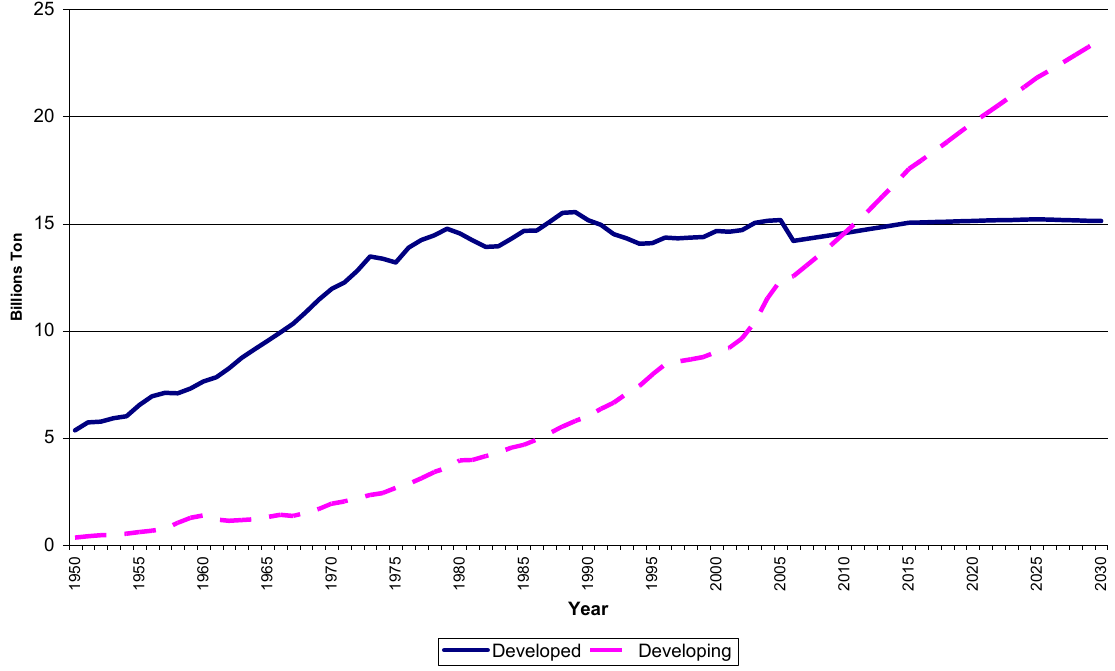
emission by developed and developing Figure 1. Trend of CO 2